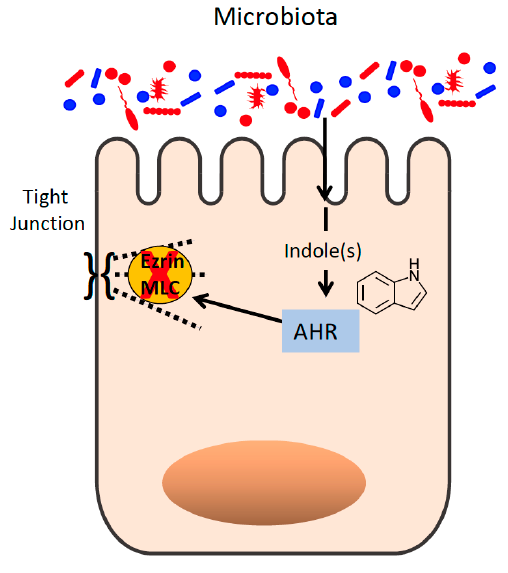
Figure 3. Microbe-derived indole regulates epithelial tight junction function. Indoles act through the aryl hydrocarbon receptor (AHR) to inhibit ezrin and myosin light-chain (MLC) kinase activity.